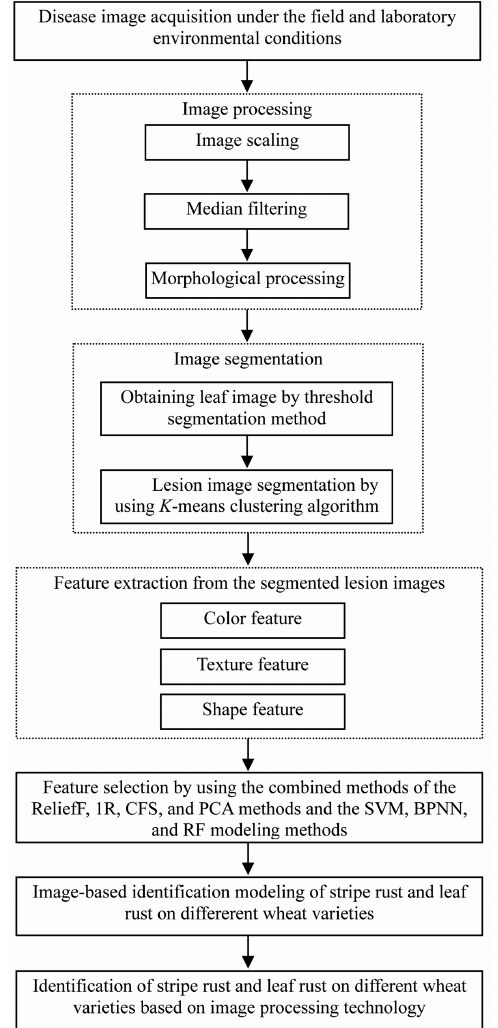
Figure 1. Workflow diagram of the main steps for image-based identification of stripe rust and leaf rust on different wheat varieties. rust on different wheat